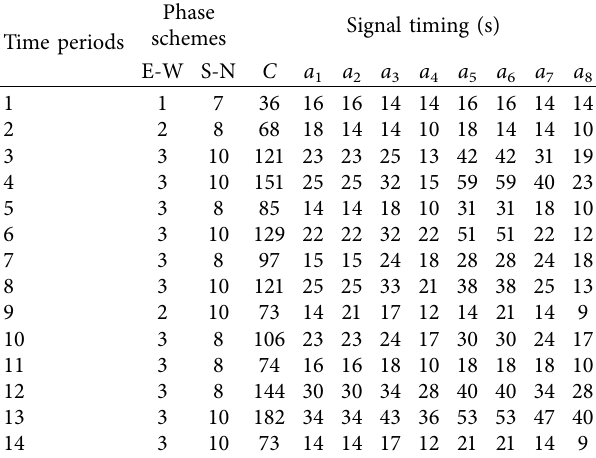
Table 3: Phase timing results of time periods of scheme A.